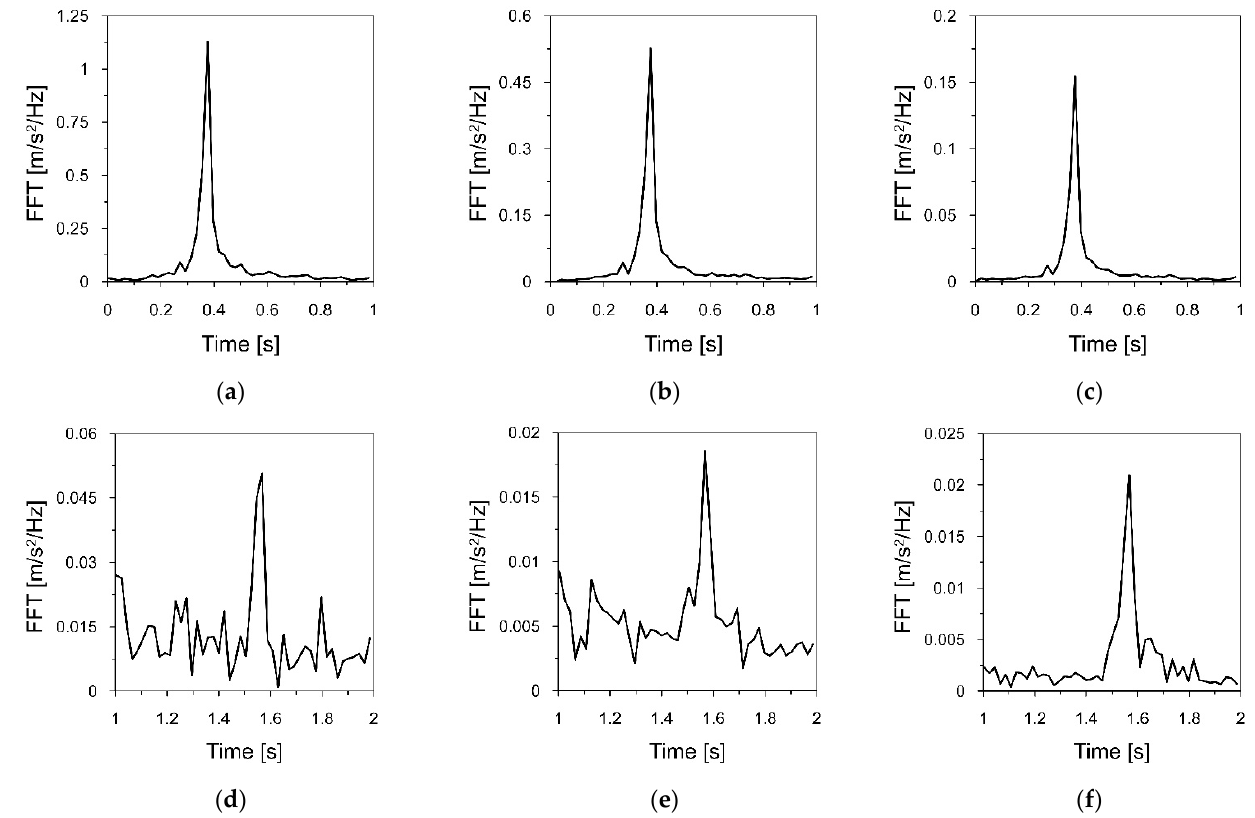
Figure 10. Fourier spectra of the acceleration − time histories that served to estimate the first natural frequency of the chimney vibration, registered at: ( a ) The highest gallery; ( b ) the middle gallery; ( c ) the lowest gallery, and the fragment of the Fourier spectra that served to estimate the second natural frequency, registered at: ( d ) The highest gallery; ( e ) the middle gallery; ( f ) the lowest gallery.